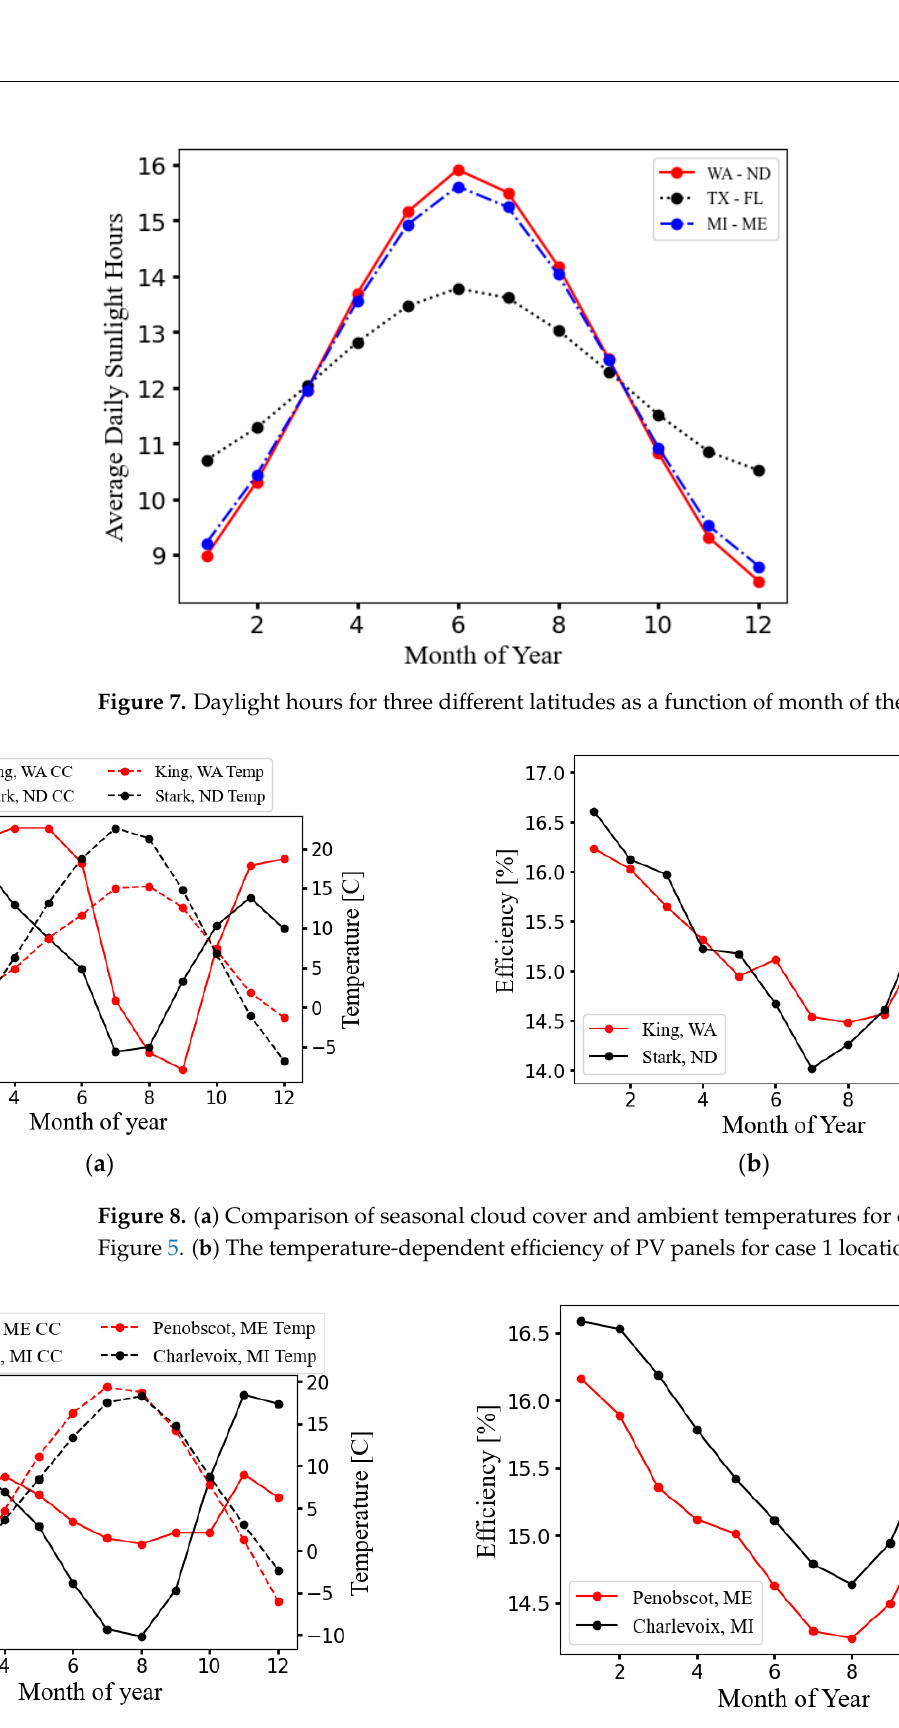
Figure 10. ( a ) Comparison of seasonal cloud cover and ambient temperatures for case 3 indicated in Figure 5. ( b ) The temperature dependent efficiency of PV panels for case 3 locations.